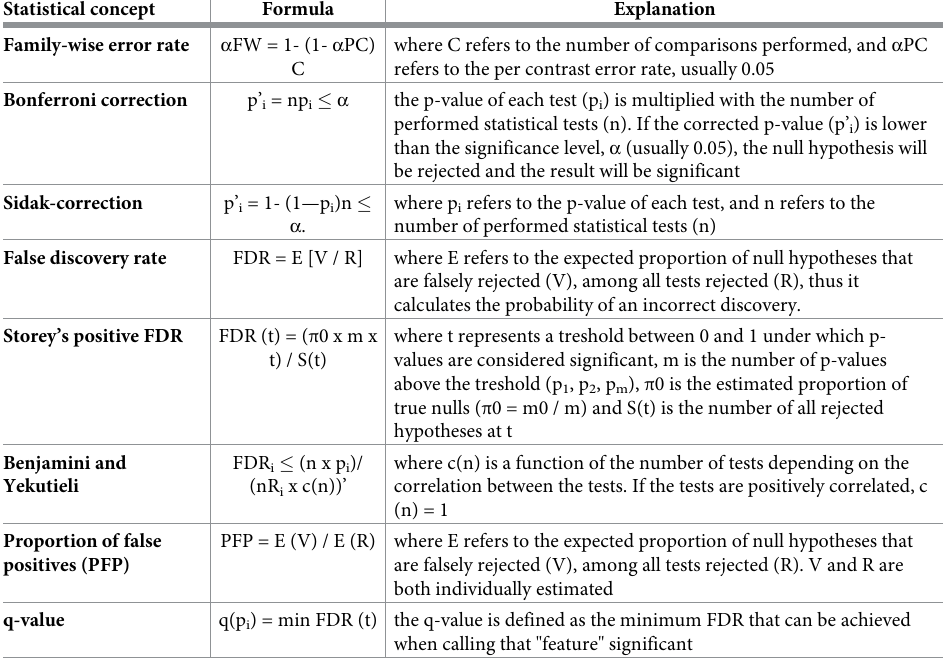
Table 1. Formulas and explanations of statistical